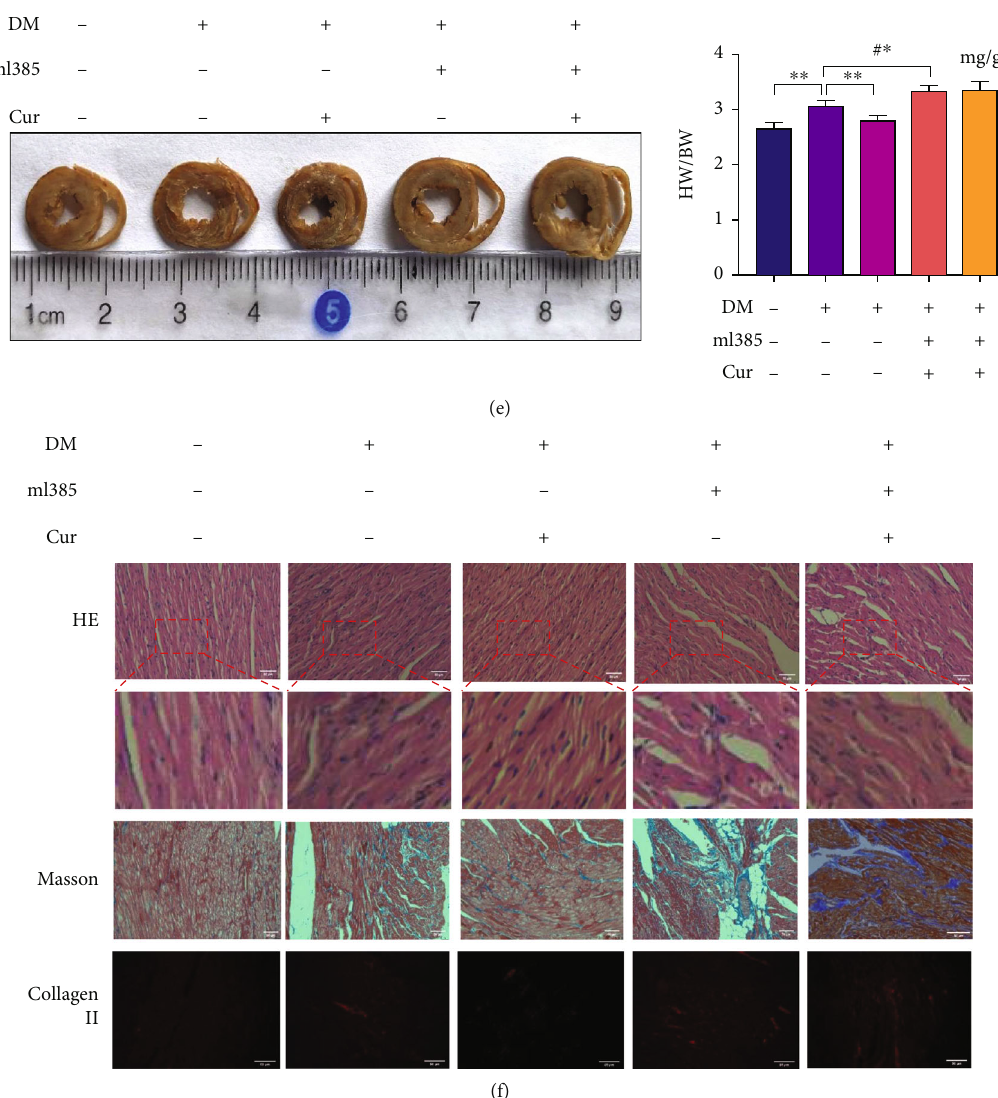
Figure 6: ml385 inhibits fl avin protective e ff ects in diabetic myocardial injury. DM: diabetic rat; Cur: curcumin; the dose used in this experiment was 200 mg/kg/day. ml385: inhibitor of the Nrf2 pathway, the dose used in the experiment was 20 mg/kg. (a) PCR and western blotting to verify the inhibitory e ff ect of ml385 on the Nrf2 pathway. (b) Detection of protein expression of the AKT/Nrf2 and pyroptosis pathways in cardiac tissue by western blotting. (c) Myocardial cross-section and the ratio of the heart weight to body weight (HW/BW). (d) Immunohistochemical results of NLRP3 and caspase-1 staining in rat myocardial tissue (20x). (e) TUNEL was used to detect the apoptosis rate of myocardial cells of rats in each group (20x). (f) Hematoxylin and eosin (HE) staining, Masson ’ s staining, and collagen II fl uorescence detection of myocardial tissue (20x). ∗∗ P < 0 : 001 : diabetic rats vs. control and curcumin-treated groups. # P < 0 : 05 : injected with ml385 vs. not injected (in diabetic rats). # ∗ P < 0 : 001 : injected with ml385 vs. not injected (in diabetic rats). Values are expressed as the mean ± standard